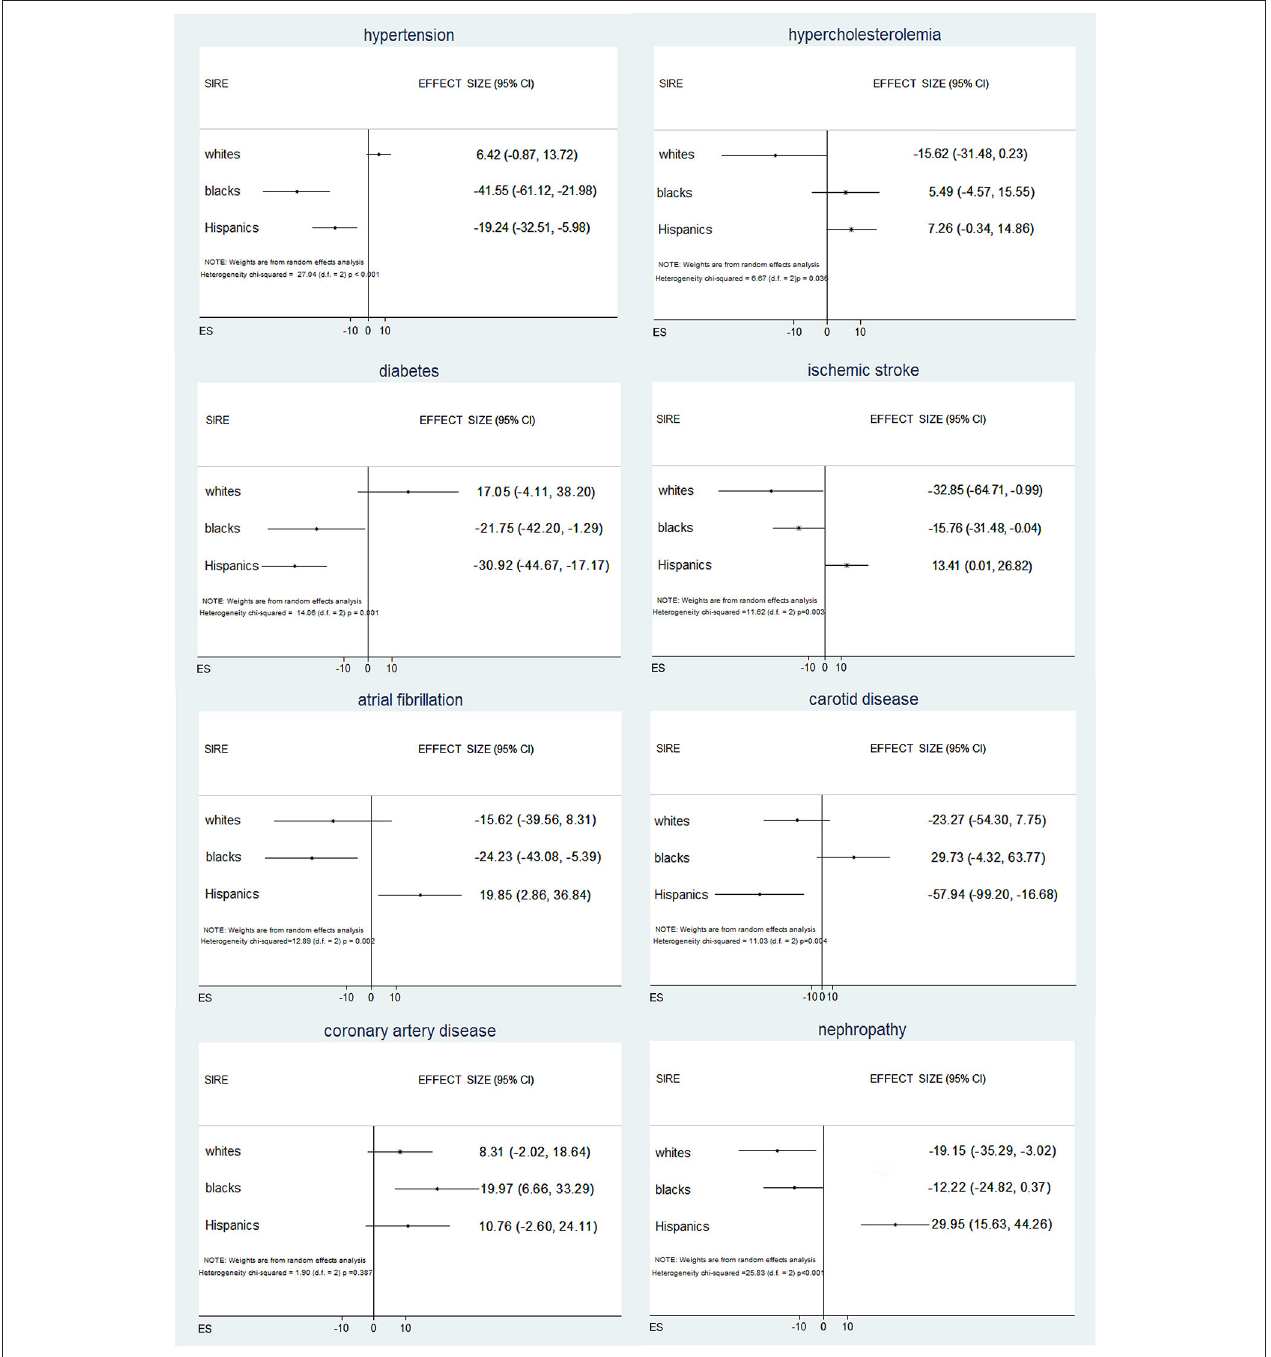
FIGURE 2 | Associations between vascular risk factors and genetic ancestry across self-identified race/ethnicities within each self-identified race/ethnicities (SIRE) group, DNA ancestry is independently associated with vascular risk factor, with differences that vary across SIRE and vascular risk